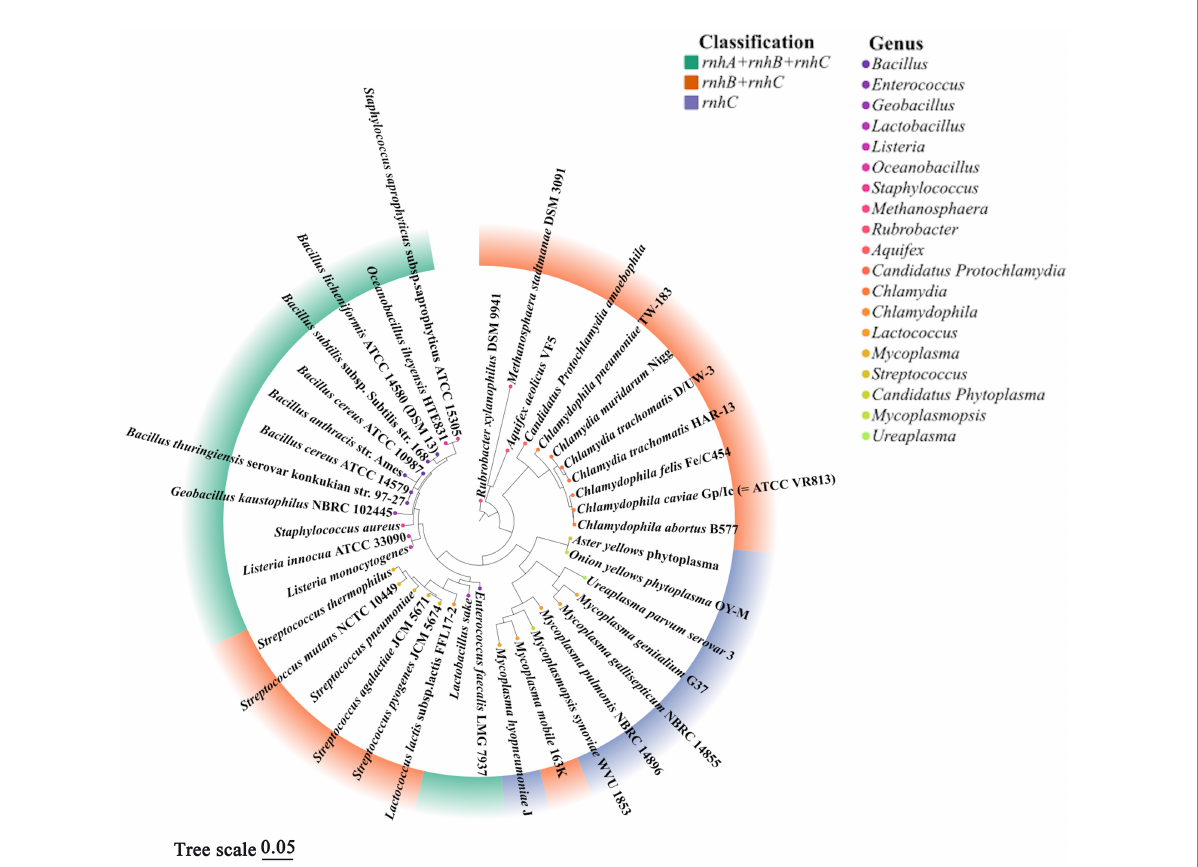
FIGURE 3 Phylogenetic tree of representative prokaryotes harboring rnh C gene. According to previous literature (Kochiwa et al., 2007) and the conservation of 16S rRNA, 40 prokaryotic organisms containing rnh C gene were chosen to align 16S rRNA sequences by CLUSTAL X2, a phylogenetic evolutionary tree was further built using MEGA 11.0 by the maximum likelihood, and the confidence limits were estimated by repetitive analyses of 1,000 bootstrapping replicates. Different colors in the outer circle of the diagram represent combinations of rnh gene, colors of points in the inner circle denote the genera of organisms. It is worth noting that not all rnh genes encode active RNase H, the fact that strains contain three rnh genes (ABC) does not mean these organisms always show activities of RNase HI, HII and HIII. This figure analyzed the evolutionary correlation of organisms according to the combinations of rnh genes but not the classification of active RNases